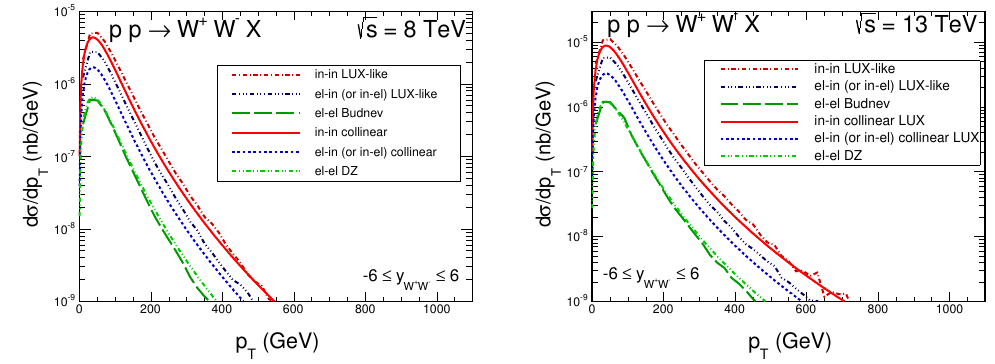
Figure 8 . Transverse momentum distribution of W + or W (cid:0) bosons for the inelastic-inelastic, elastic-inelastic, inelastic-elastic and elastic-elastic contributions for LUX-like structure function compared to the relevant distribution for collinear approach with the LUXqed. The left panel p shows results for s = 8 TeV, while the right panel shows results for